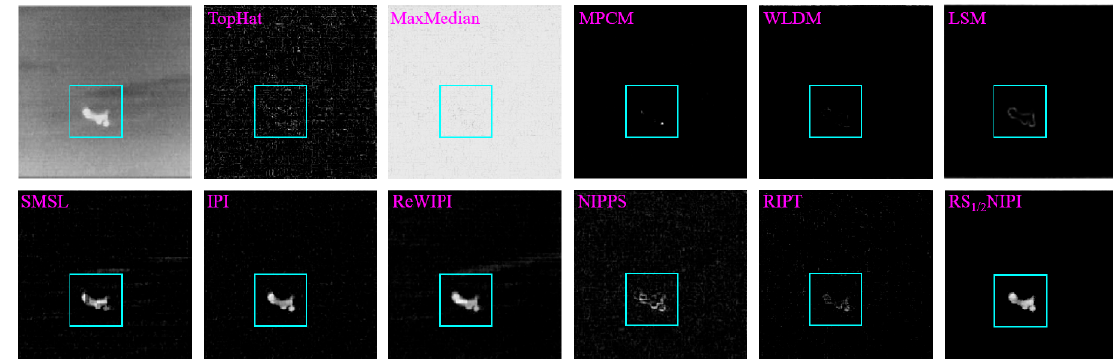
Figure 14. An example of structurally sparse target scenes and the corresponding detection results obtained by the proposed method compared with ten competitive methods.